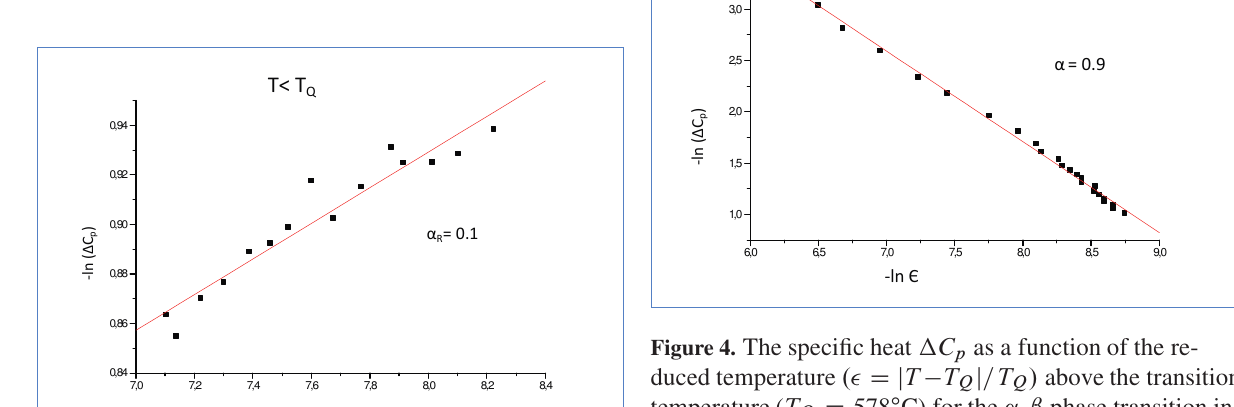
Figure 1. The specific heat (cid:3)C p as a function of the re- duced temperature .(cid:4) D j T (cid:2) T Q j =T Q / below the tran- sition temperature ( T Q D 578 ı C) for the ˛ - ˇ phase tran- sition in quartz according to Eq. (2). ˛ R represents the renormalized critical exponent for the specific heat (cid:3)C p from Eq. (3).